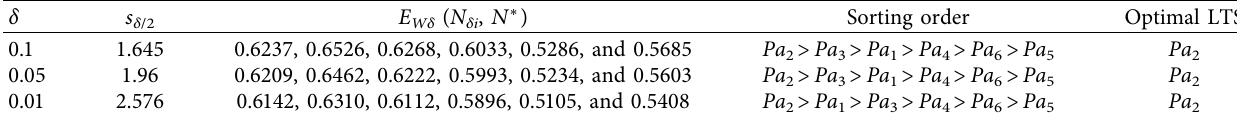
Table 1: Decision results subject to the 90%, 95%, and 99% confdence levels.